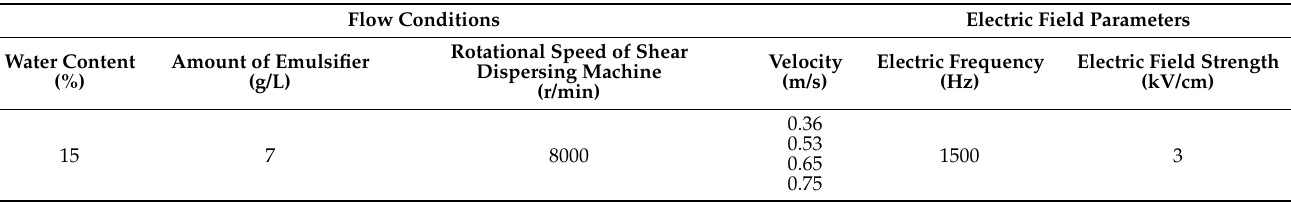
Table 4. Parameters to study the influence of emulsion velocity.